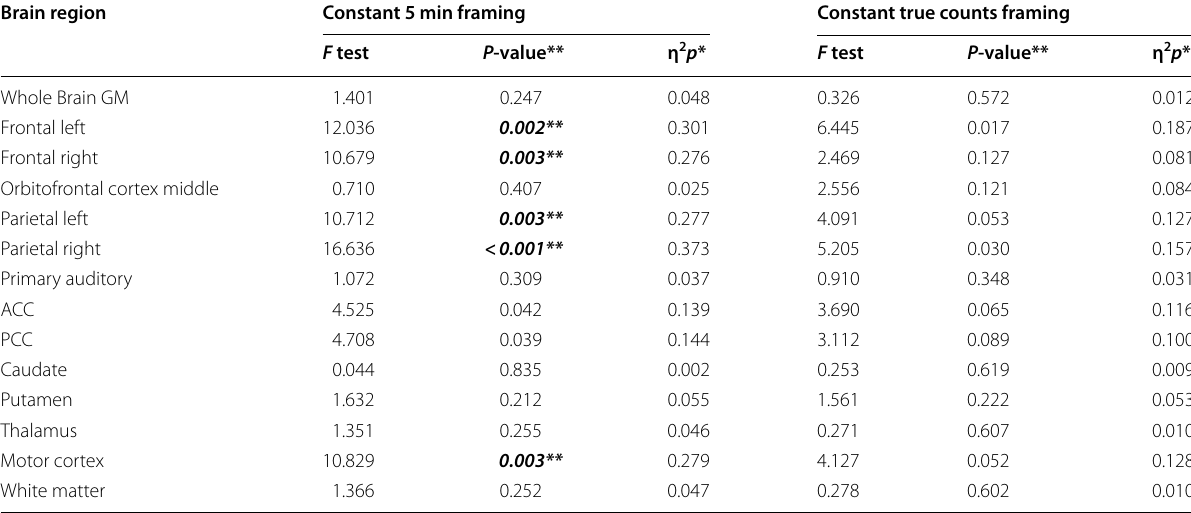
in the comparison between the HC and SZ groups separated by framing scheme ND